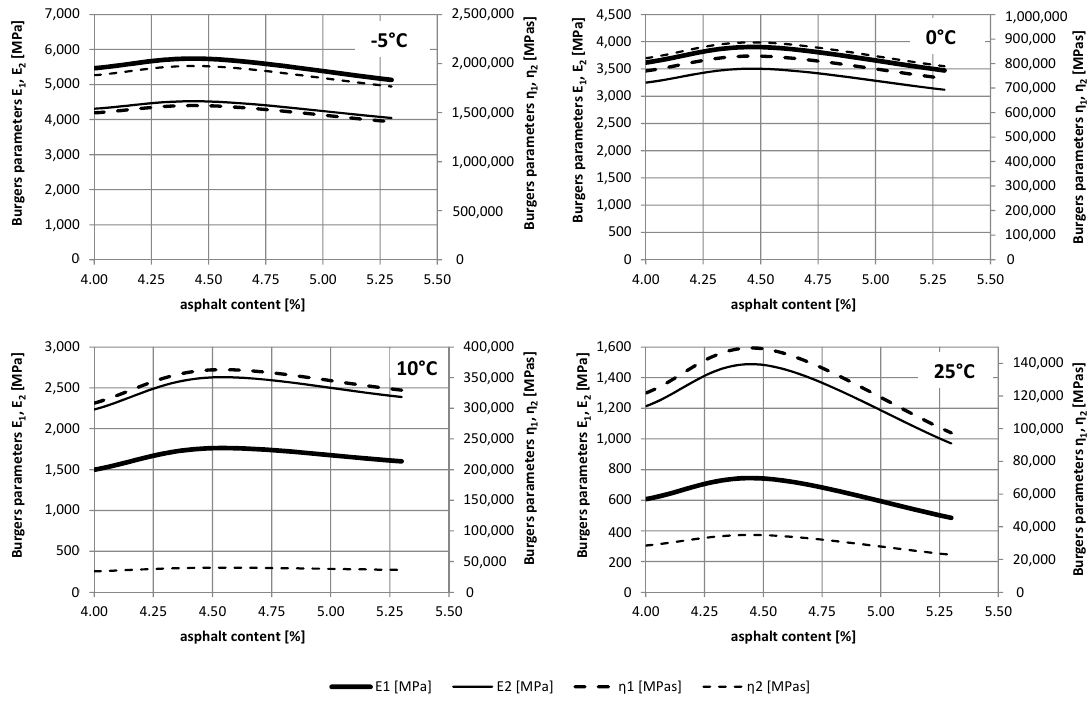
Figure 11. The relationship of Burgers parameters on the temperature in the static test.